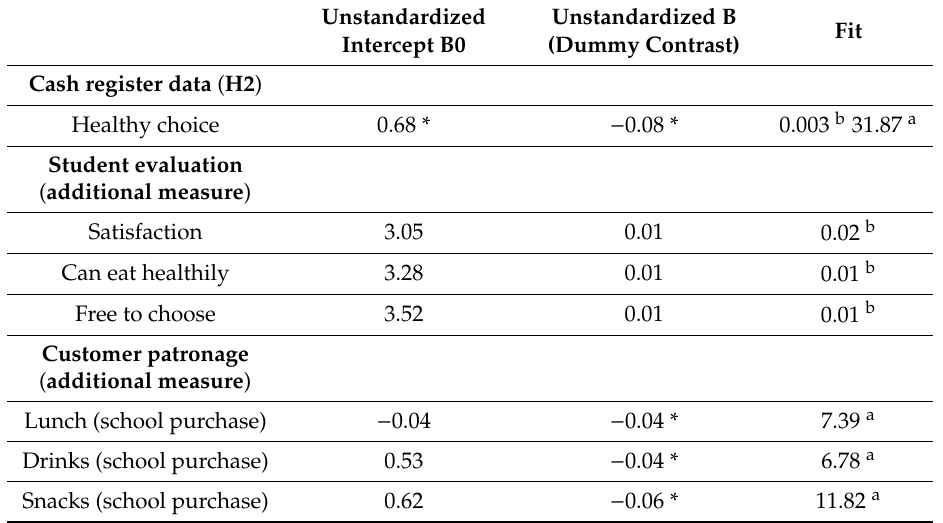
Table 6. Regression results hypothesis 2 and additional measures.